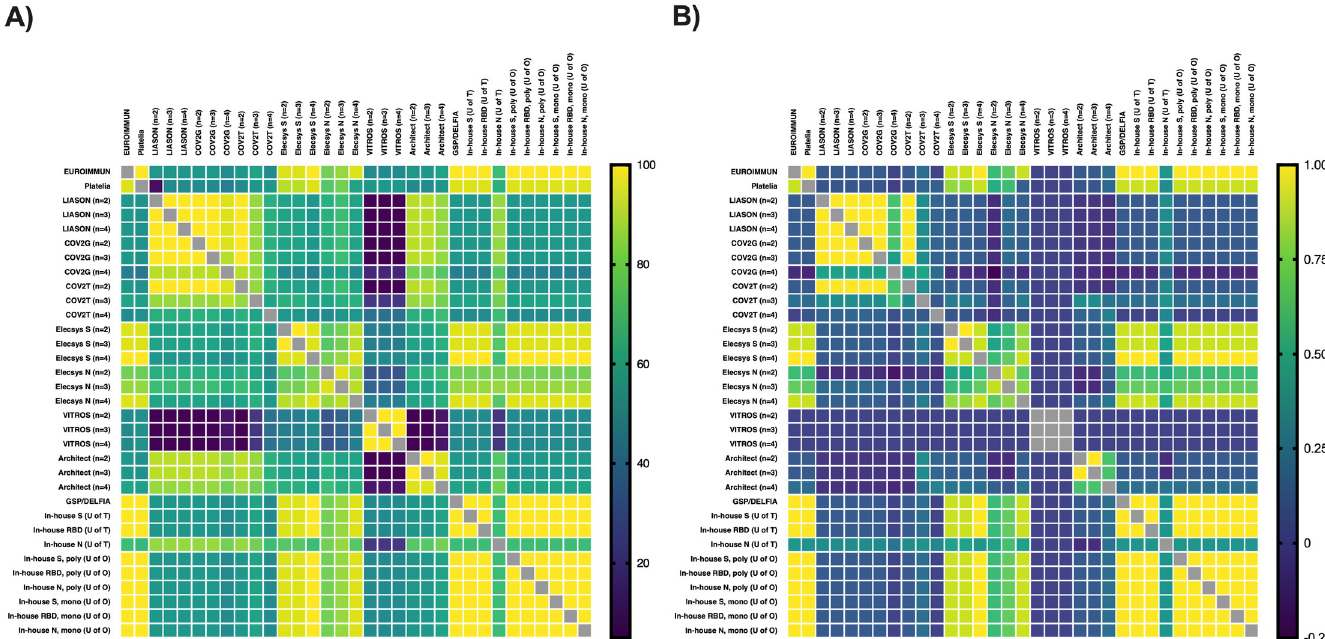
Fig 2. Inter-assay concordance (A) and Cohen’s kappa coefficient (B) for SARS-CoV-2 antibody testing on dried blood spot specimens. Concordance (%) and Cohen’s kappa coefficient are presented for n = 10 SARS-CoV-2 antibody negative DBS specimens and n = 10 SARS-CoV-2 antibody positive DBS specimens. One 6 mm (1/4 inch) punch was used for the EUROIMMUN assay and two 6 mm (1/4 inch) punches were used for the Platelia and in-house assays. EUROIMMUN = Anti- SARS-CoV-2 ELISA assay (EUROIMMUN, Lu¨beck, Germany). Platelia = SARS-CoV-2 assay (Bio-Rad, Hercules, California). LIASON = SARS-CoV-2 assay (DiaSorin, Saluggia, Italy). COV2G = SARS-CoV-2 COV2G assay (Siemens, Erlangen, Germany). COV2T = SARS-CoV-2 COV2T assay (Siemens). Elecsys S = Quantitative Anti- SARS-CoV-2 assay (Elecsys spike; Roche, Basel, Switzerland). Elecsys N = Anti-SARS-CoV-2 assay (Elecsys nucleocapsid; Roche). VITROS = Anti-SARS-CoV-2 assay (Ortho Clinical Diagnostics, Raritan, New Jersey). Architect = SARS-CoV-2 assay (Abbott, Mississauga, Canada). GSP/DELFIA = Anti-SARS-CoV-2 assay (PerkinElmer, Waltham, Massachusetts). In-house S (U of T) = In-house spike assay (University of Toronto). In-house RBD (U of T) = In-house RBD assay (University of Toronto). In-house N (U of T) = In-house nucleocapsid assay (University of Toronto). In-house S, mono (U of O) = In- house monoclonal spike assay (University of Ottawa). In-house RBD, mono (U of O) = In-house monoclonal RBD assay (University of Ottawa). In-house N, mono (U of O) = In-house monoclonal nucleocapsid assay (University of